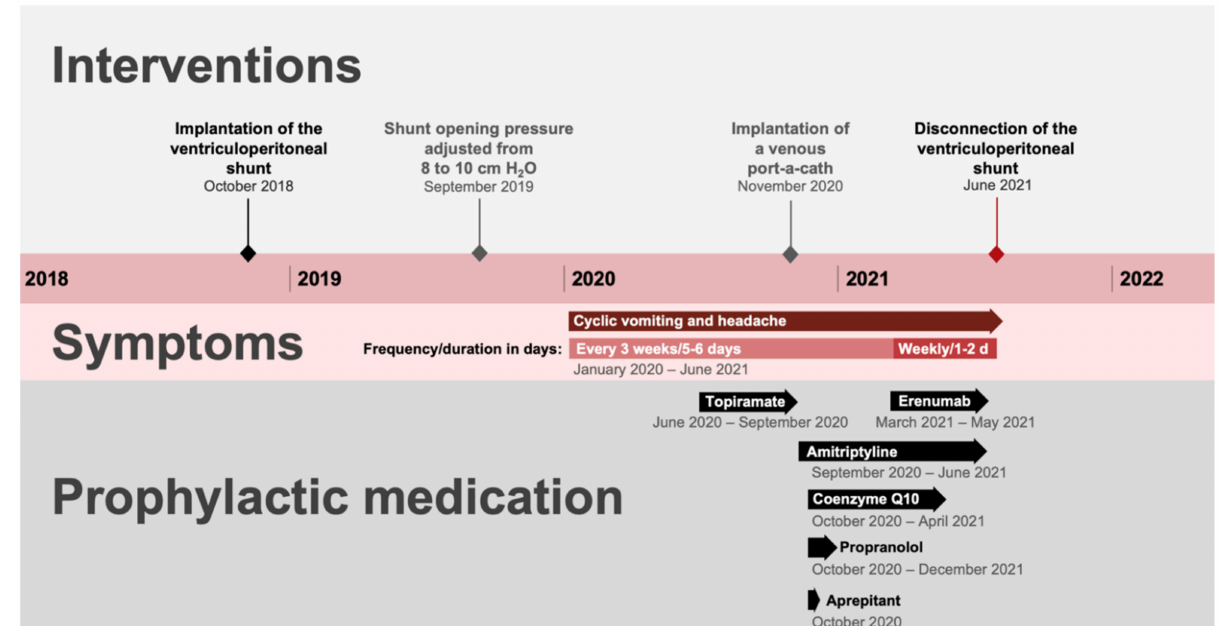
Figure 1. Timeline of interventions, symptoms, and prophylactic